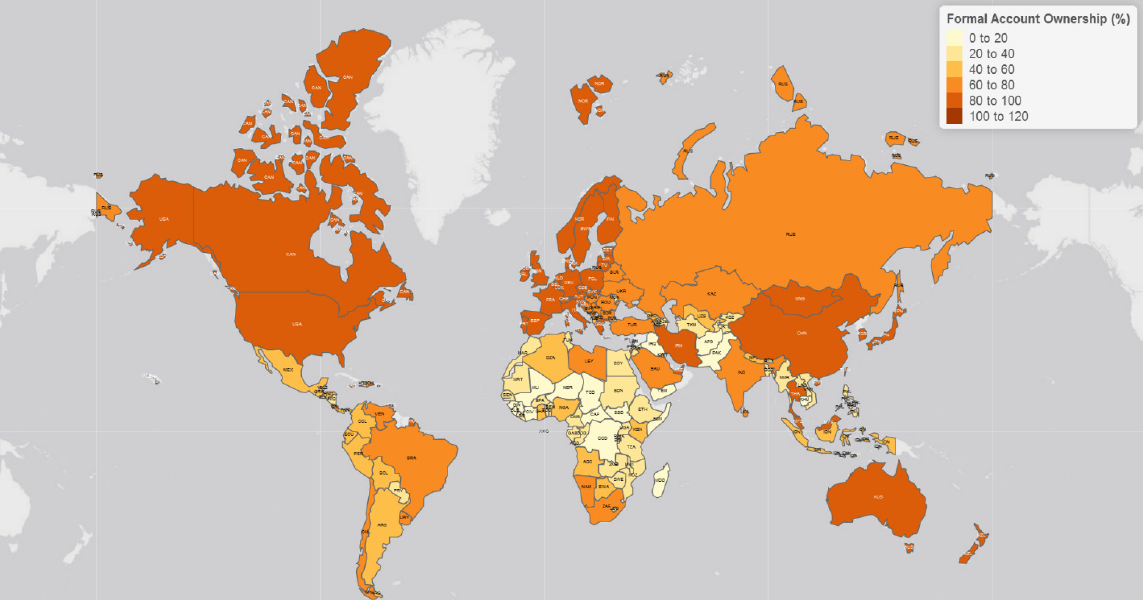
Figure A2. Country level weighted proportion (percentage) of formal account owners between 2014 and 2017 globally. Source: Author’s own construction using the global financial inclusion surveys (2014 and 2017). (See dynamic web link at https://rpubs.com/brassbe1982/formalAccountOwn_figb2 (accessed on 21 December 2021))